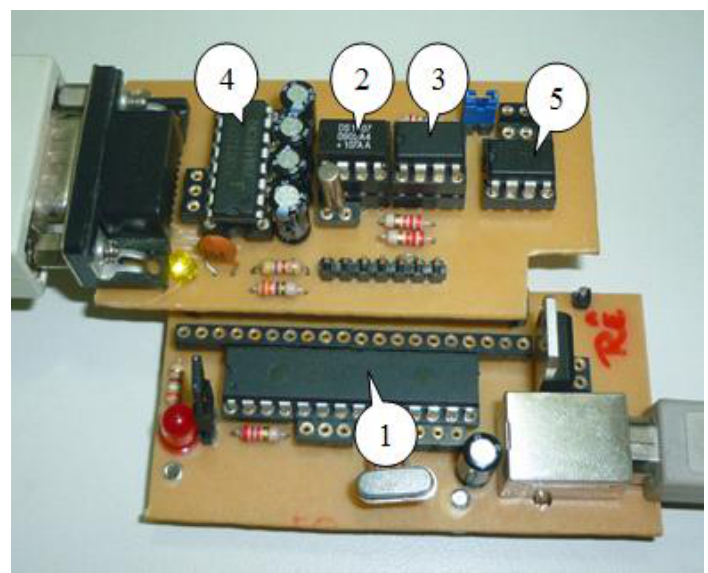
Figure 1. Developed low cost DAS card.